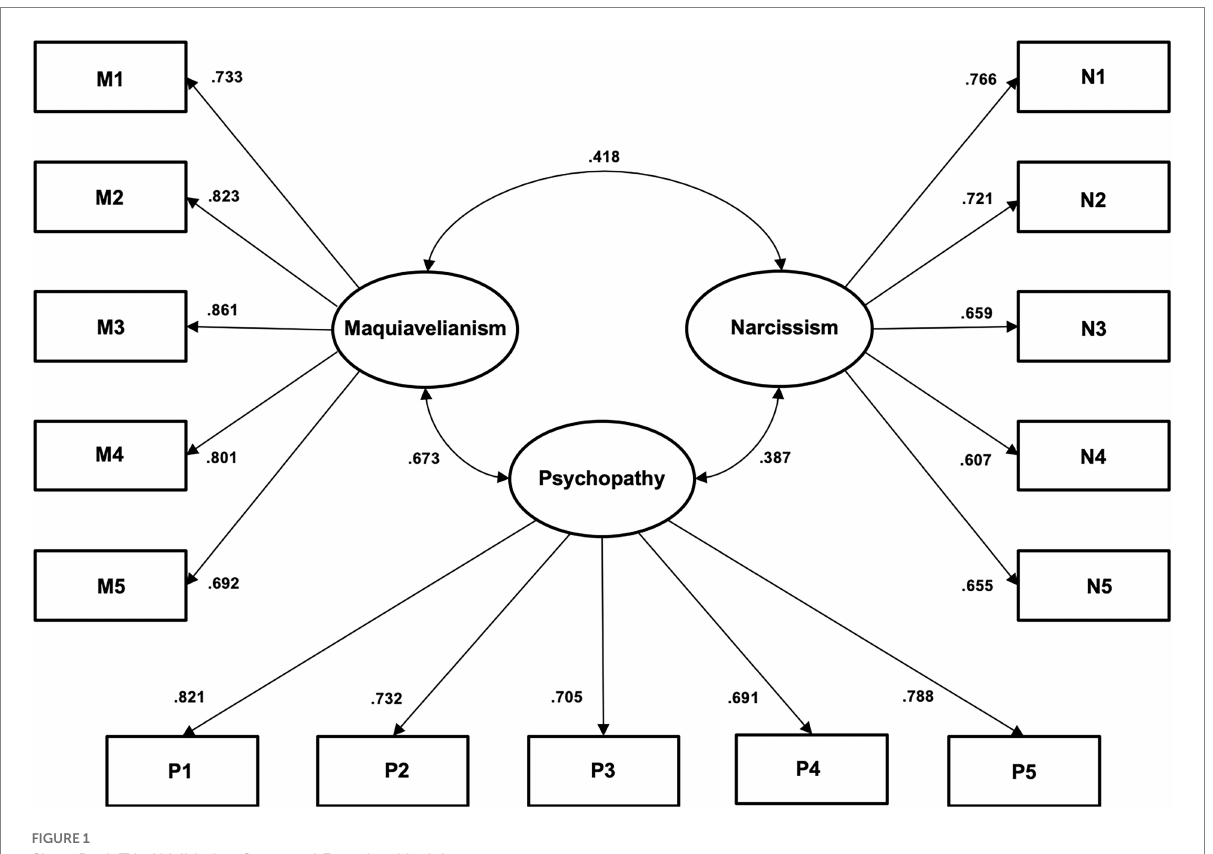
FIGURE 1 Short Dark Triad Validation Structural Equation Model.